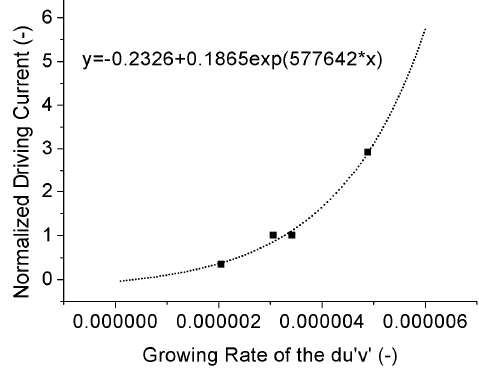
Figure 15. Current effect on the growth rate of the du ’ v ’ .